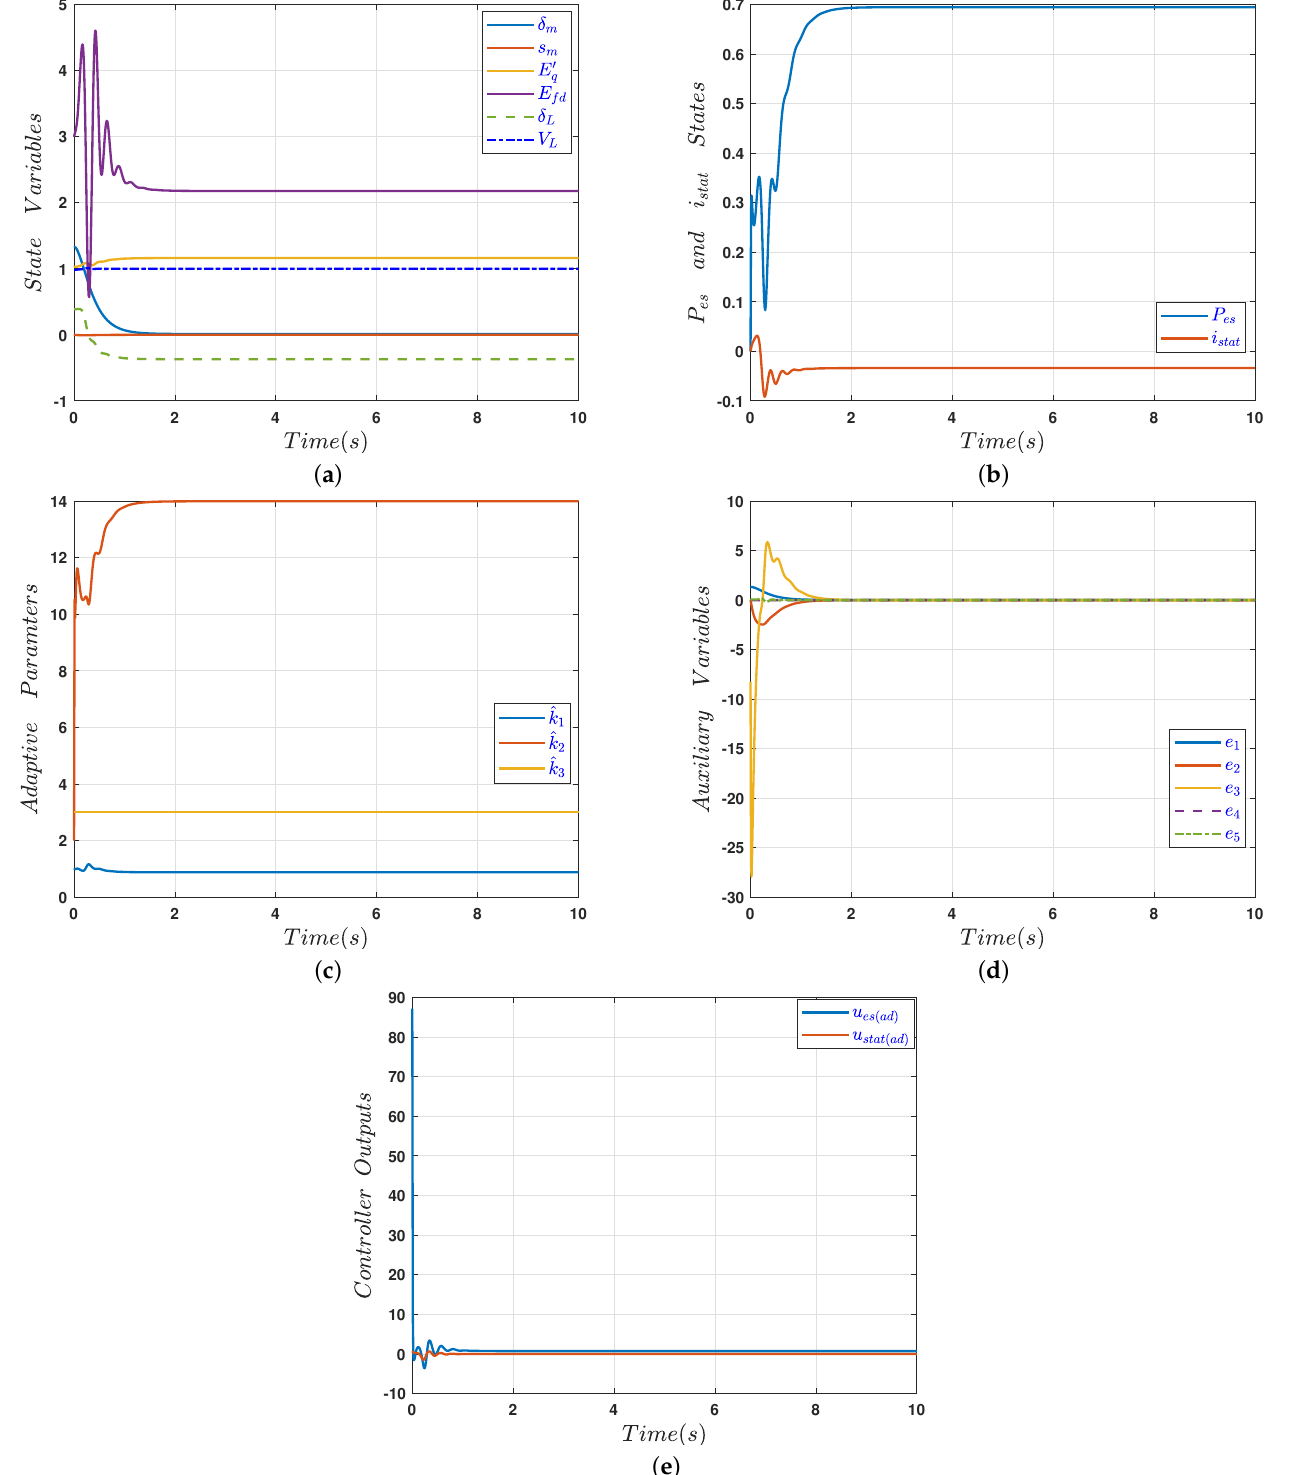
Figure 5. The results of the first control scenario. ( a ) Controlled power system (12) state variables time series with control in action at t = 0 ( s ). ( b ) Energy storage device and the STATCOM current states. ( c ) The controller adaptive parameters time evolution. ( d ) The controlled auxiliary variables states times series. ( e ) The controller outputs with control in action at t = 0 ( s